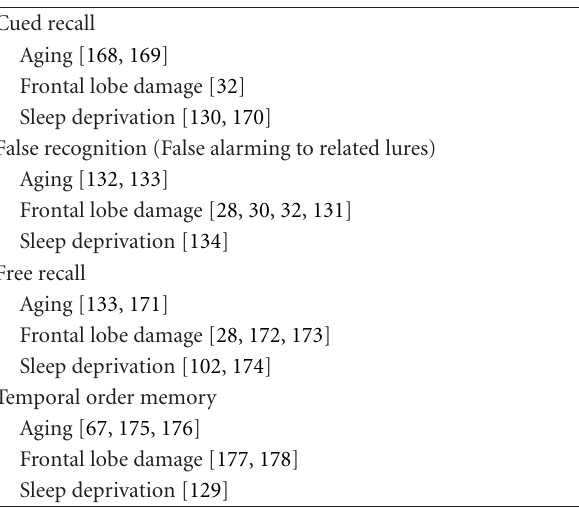
Table 2: Retrieval processes influenced by advanced aging, PFC damage, and sleep deprivation. Simple item recognition is thought not to depend on the PFC except under conditions in which subjects are required to distinguish between studied items and unstudied items semantically related to studied items (false recognition). Some e ff ects of aging, PFC, and sleep deprivation on these memory pro- cesses are attributable to impairments in both retrieval as well as encoding